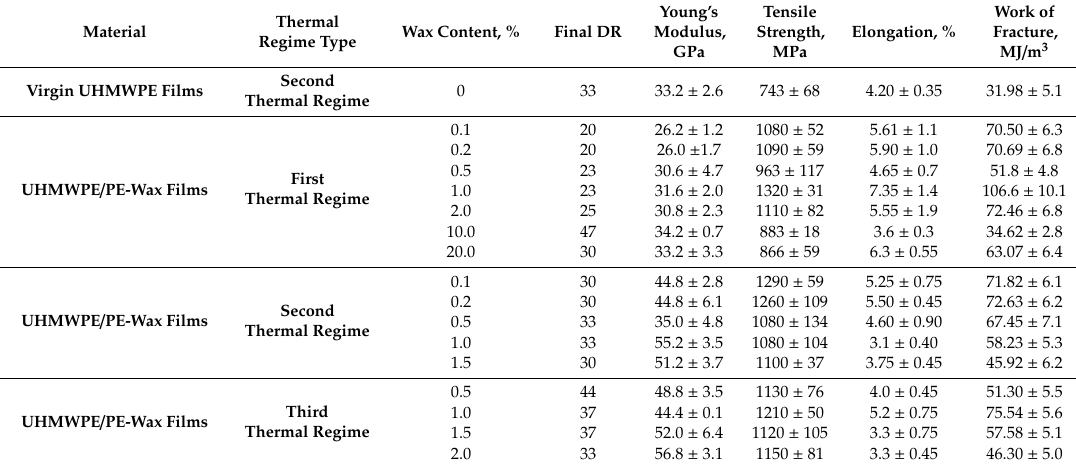
Table 1. Mechanical tensile properties of the UHMWPE / PE-wax films with di ff erent PE-wax content for all thermal regimes ( ± the standard